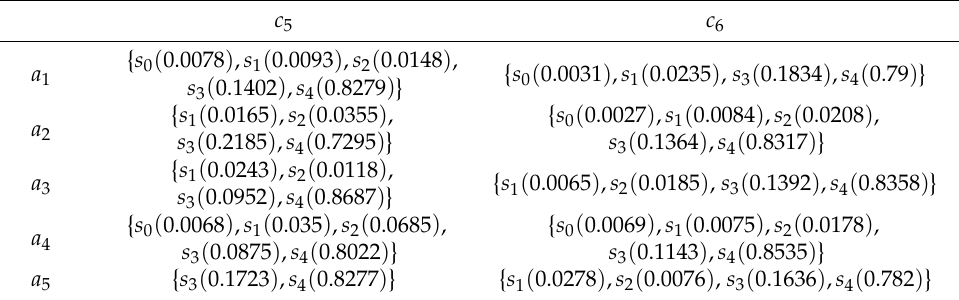
Table 3. Evaluation values for each hotel under criteria c 5 and c 6